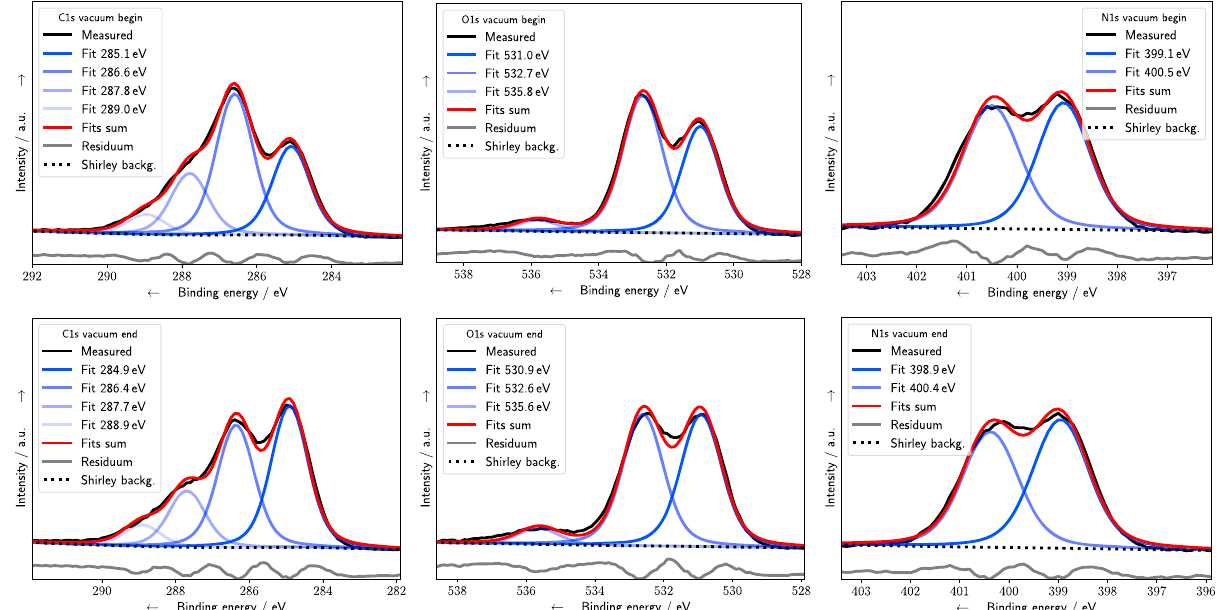
Fig. 2 XPS spectra under vacuum conditions. C1s (left column), O1s (central column), and N1s (right column) spectra are shown at the beginning (top row) and end (bottom row) of the exposure. In addition, Voigt peak fi ts (blue), the sum (red), the Shirley background (black dotted curve), and fi tting residuals (gray) are also shown. Residuals were shifted to lower y values.